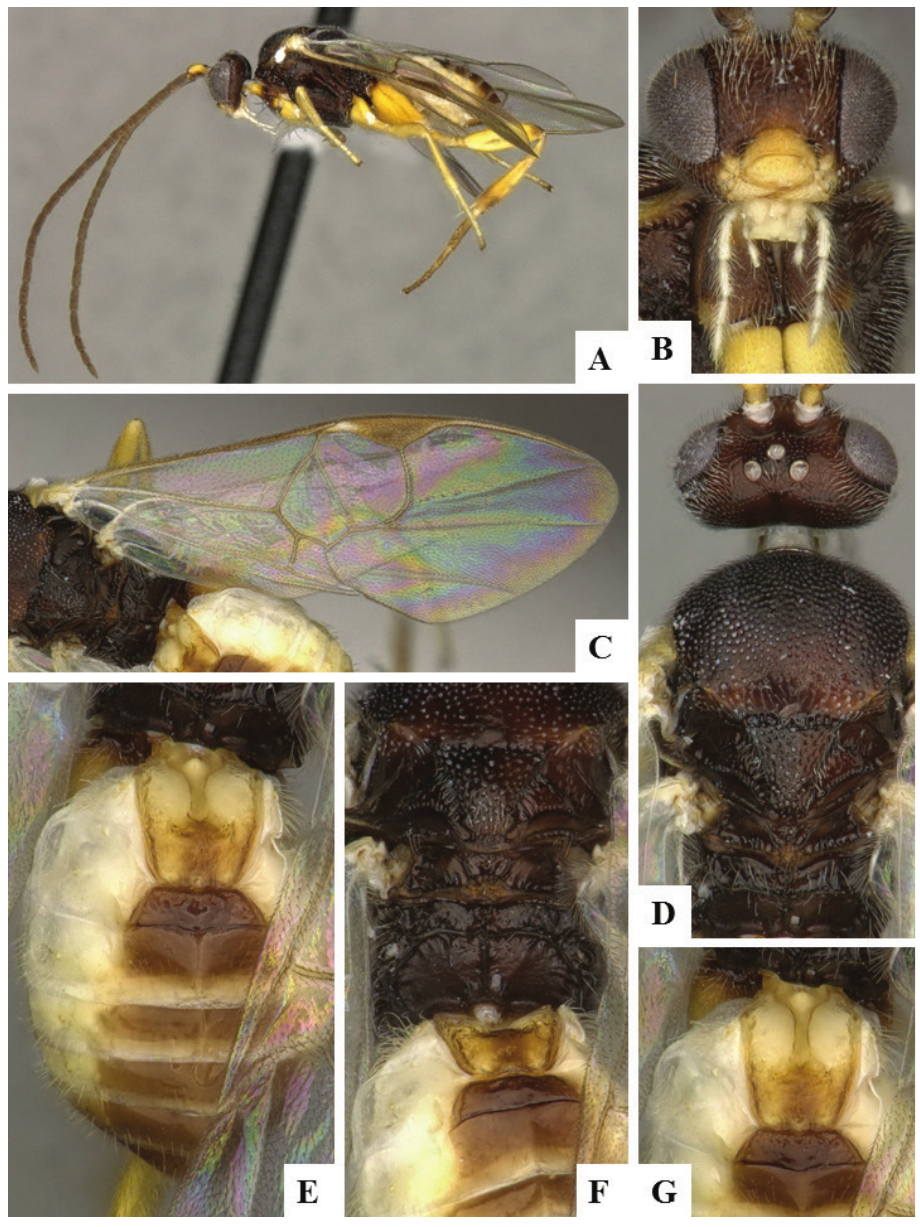
Figure 16. Janhalacaste guanacastensis male paratype DHJPAR0052309. A Habitus B Head frontal C Fore wing D Head and mesosoma, dorsal E Metasoma dorsal F Propodeum G Tergites 1 and 2. eyes, mostly covered by relatively long and dense setae (except for smooth, setose- less area, centrally on occiput behind ocelli, Fig. 15D). Anteromesoscutum and scutellar disc with relatively deep and close punctures, and with long, white